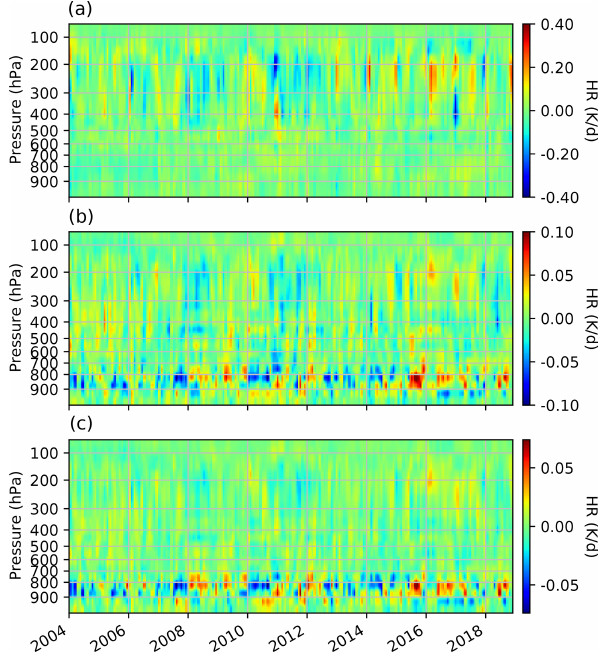
Figure 12. Time series of deseasonalized anomalies of 24h net cloud heating and cooling effects of MCSs (a) and of clouds (b) , when present, and the CRE (c) .